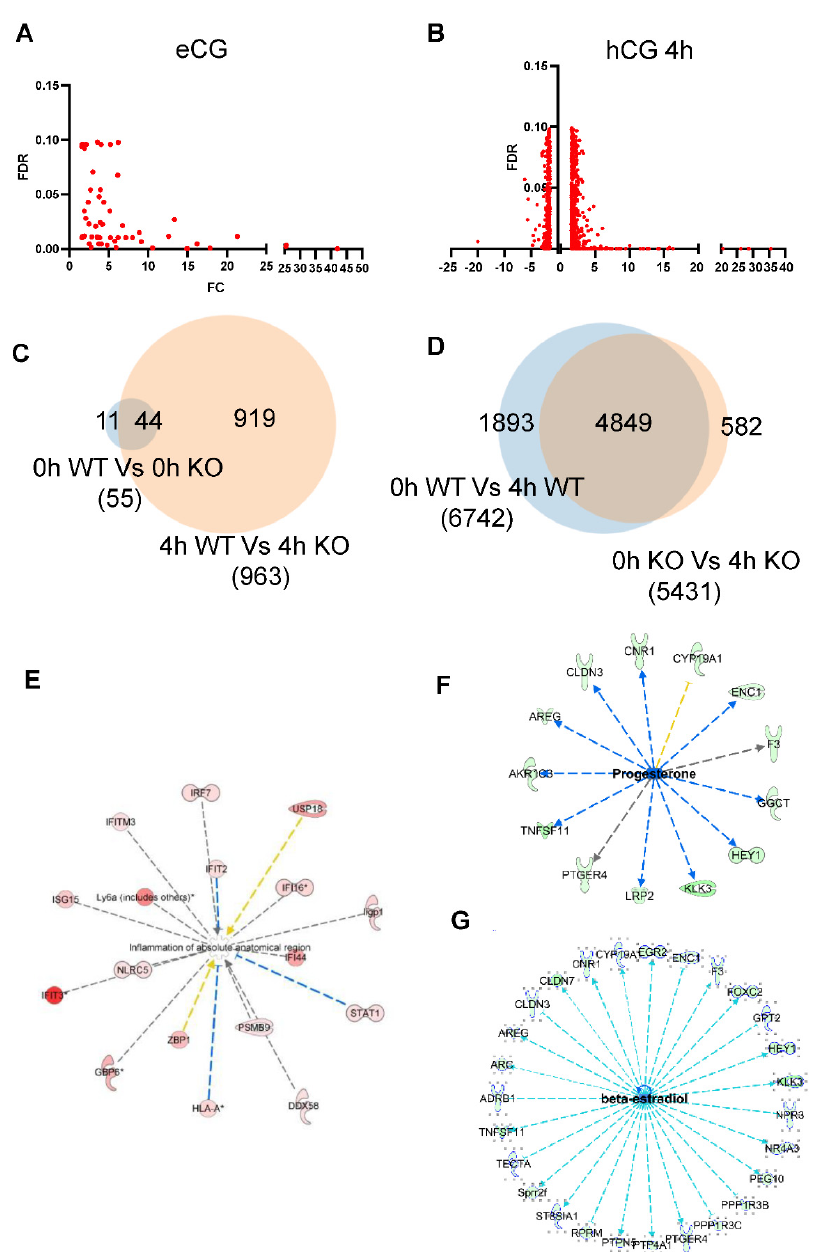
Figure 4. RNA seq analyses of gc Adar KO granulosa cells. ( A ) Volcano plot showing DEGs with fold change ≥ 1.5, FDR ≤ 0.1, between WT versus gc Adar KO granulosa cells 46 h after eCG injection. Each dot represents a gene. Total there are only 55 upregulated genes. ( B ) Volcano plot showing DEGs with fold change ≥ 1.5, FDRP ≤ 0.1, between WT versus gc Adar KO granulosa cells 4h after hCG injection in eCG primed mice. Each dot represents a gene. ( C ) Venn diagram comparing differentially expressed genes (DEGs) between WT versus gc Adar KO GCs 46 h after eCG injection and 4 h after hCG injection in eCG primed mice. ( D ) Venn diagram comparing DEGs 46 h after eCG versus 4 h after hCG injection in eCG primed mice in WT and gc Adar KO. ( E – G ) IPA analysis revealed three major pathways related to ovarian physiology. ( E ) Inflammation pathway, all genes were highly upregulated in gc Adar KO mice granulosa cells. * Denotes significant upregulated genes ( p < 0.05). ( F ) progesterone and ( G ) estradiol downstream signaling pathways were identified and all of these genes were slightly